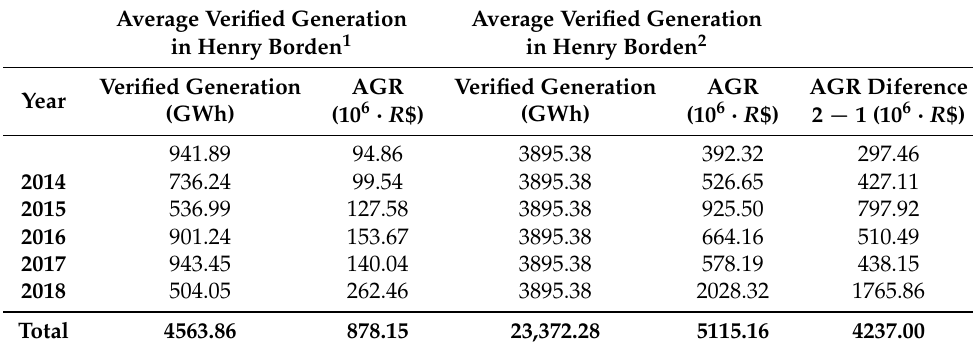
Table 5. Invoiced electricity and revenue potential of Henry Borden for Scenario 02.